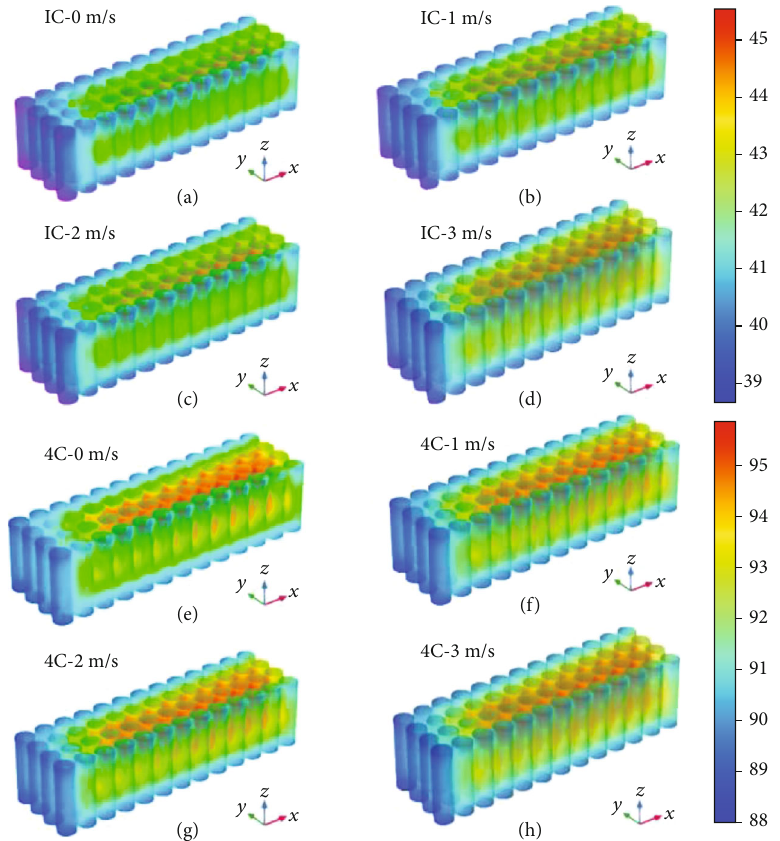
Figure 8: Temperature distribution nephogram of the battery